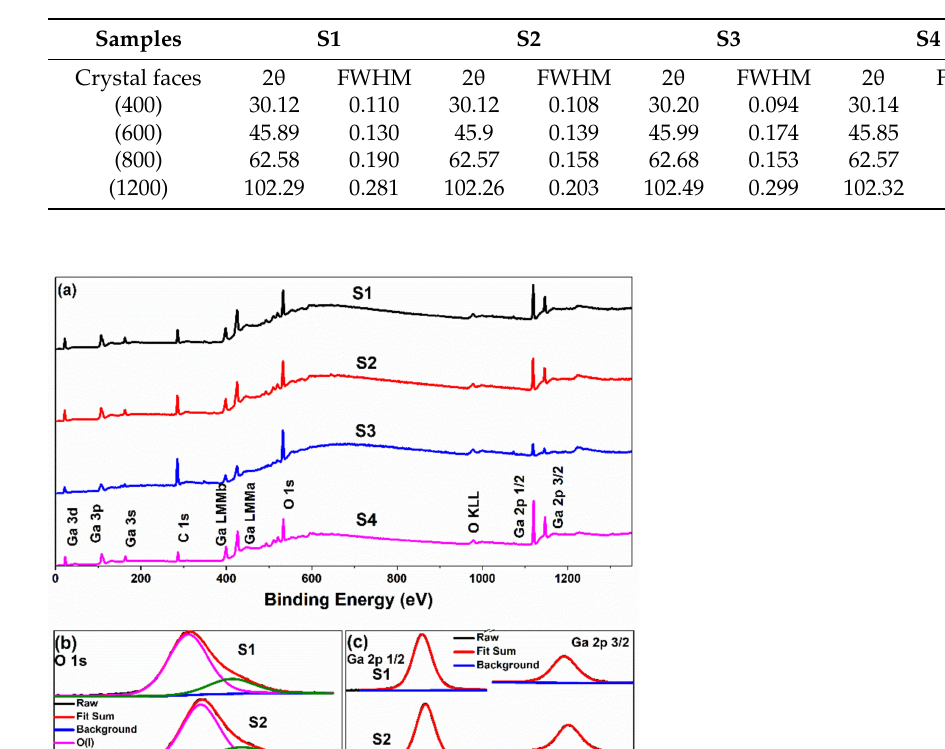
Table 1. The results of HR-XRD for four β -Ga 2 O 3 :Nb samples.